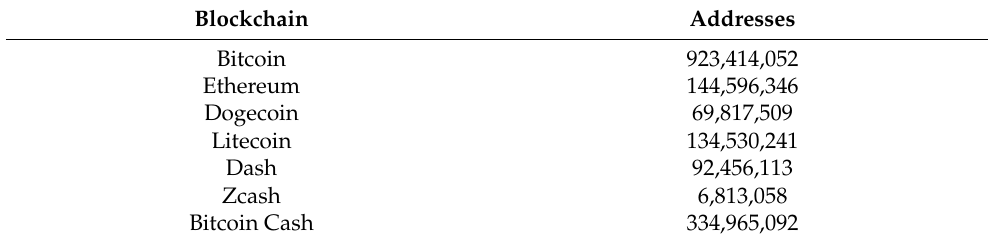
Table 1. Number of examined addresses.